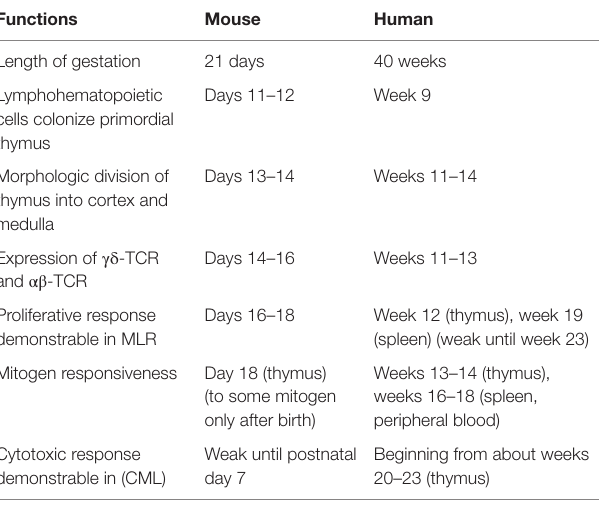
TABLe 1 | Comparison of immune maturation between mouse and human (5).